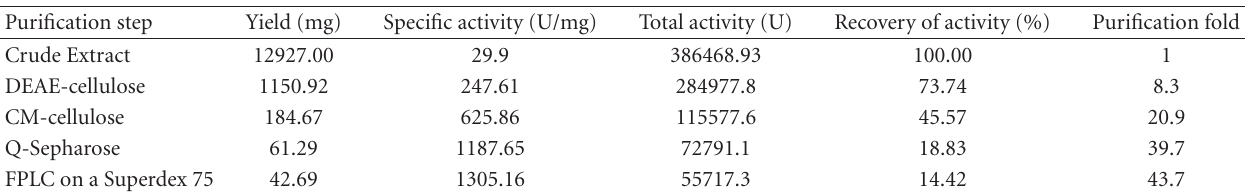
Table 1: Yields and laccase activities at each purification step (from 500 g A. placomyces fresh fruiting body, activity assayed at 30 ◦ C).